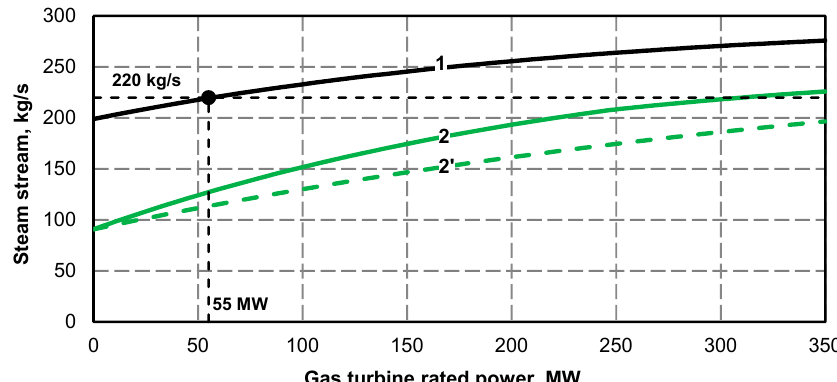
Figure 26. The stream of outlet steam from the low-pressure steam turbine part to the KQ1 condenser as a function of gas turbine rated power: 1 — maximum fixed stream of 319.4 kg/s fresh steam fed to steam turbine; 2 — minimum steam boiler output of 133.3 kg/s and gas turbine operating at a rated power, 2’ — minimum steam boiler output of 133.3 kg/s and gas turbine operating with 60% of its rated power.